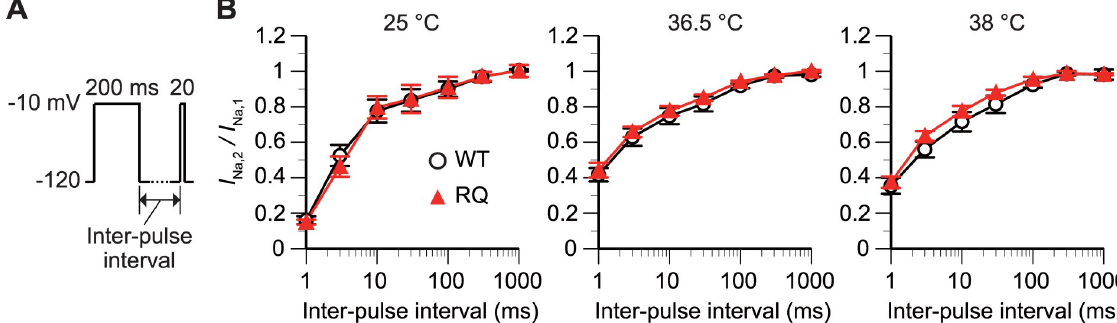
Fig 4. SCN5A(R1193Q) did not affect the recovery from inactivation at any tested temperature. (A and B) The time dependence of recovery from inactivation was measured with a triple-step voltage protocol (A). The inter-pulse interval varied from 1 to 1000 ms. The graph (B) plots the ratio of the I Na amplitude evoked at the second depolarizing step to the I Na amplitude evoked at the first depolarizing step ( I Na,2 / I Na,1 ) against the inter-pulse interval. p > 0.05 between WT and RQ cells (rmANOVA). n, 5 WT and 5 RQ cells for each